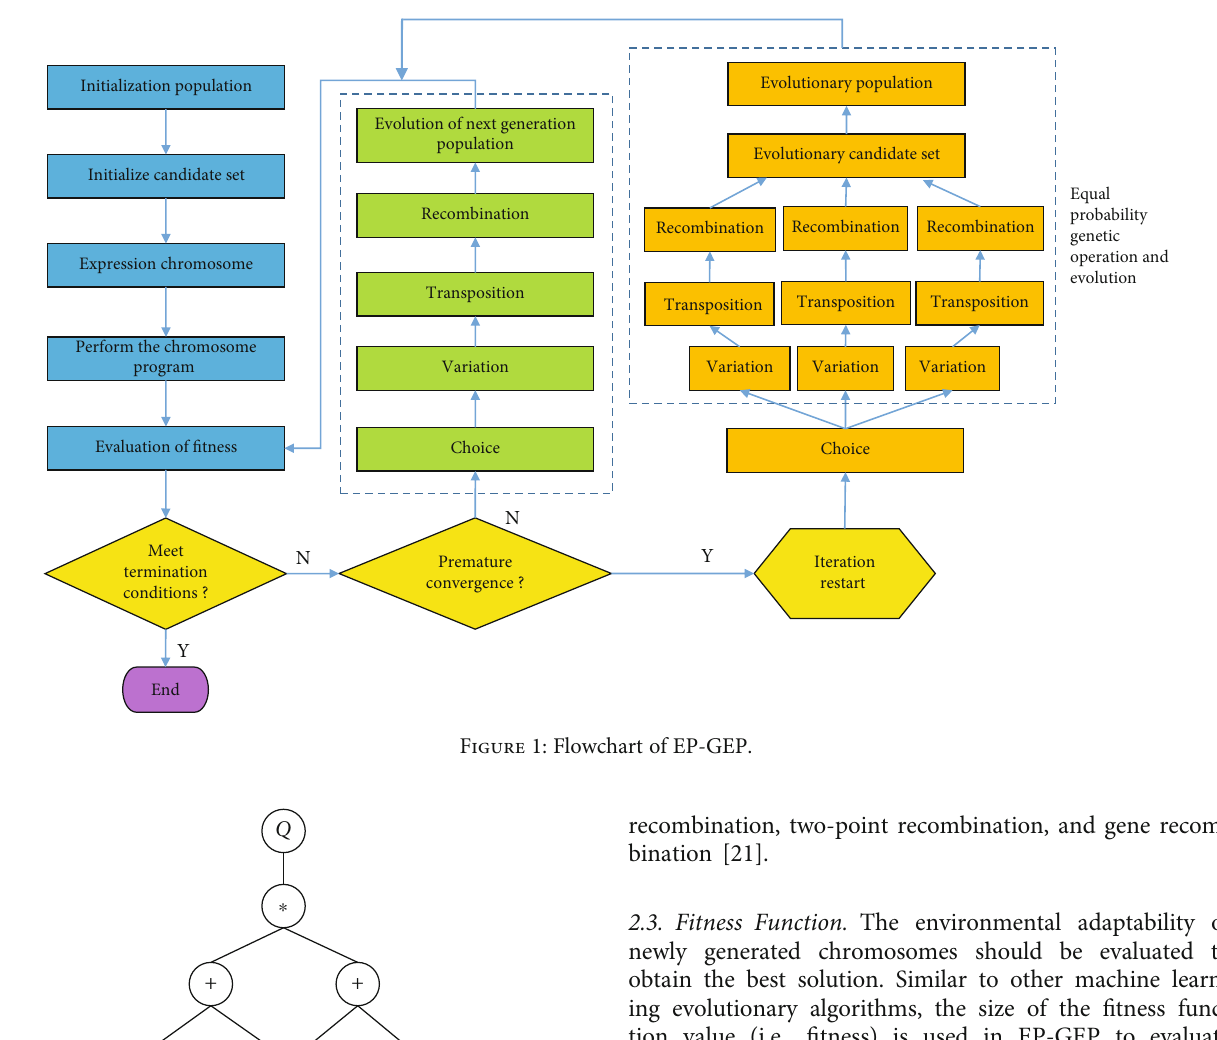
Figure 2: Expression tree corresponding to expression